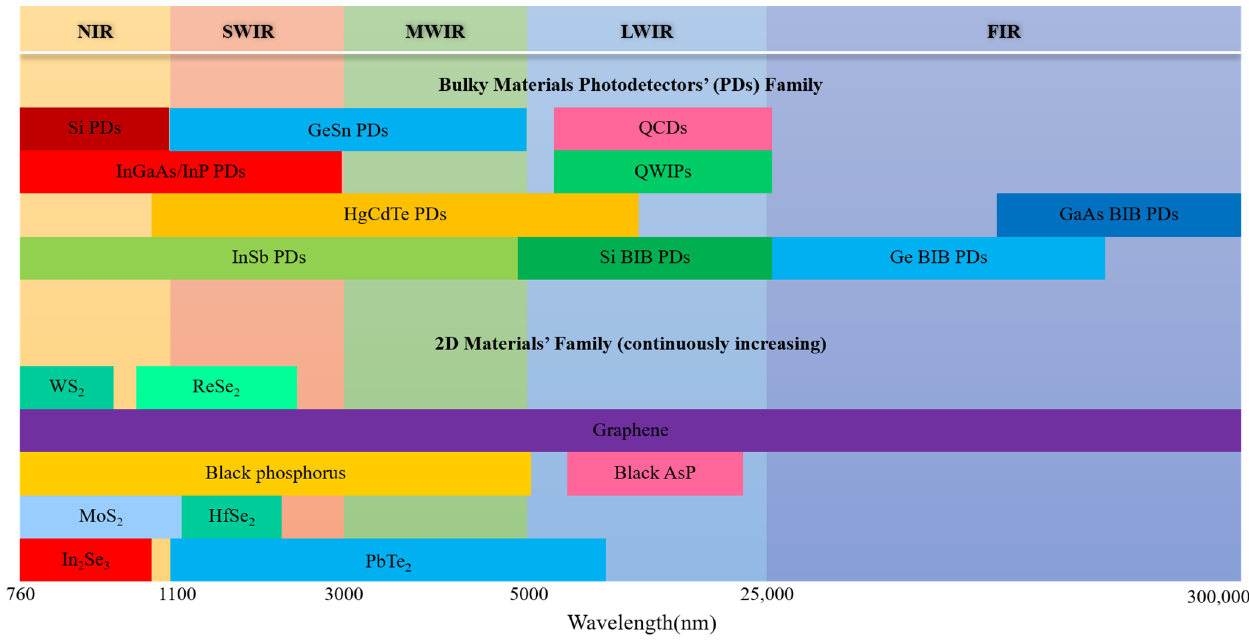
Figure 1. Some typical bulky photodetectors and 2D materials versus